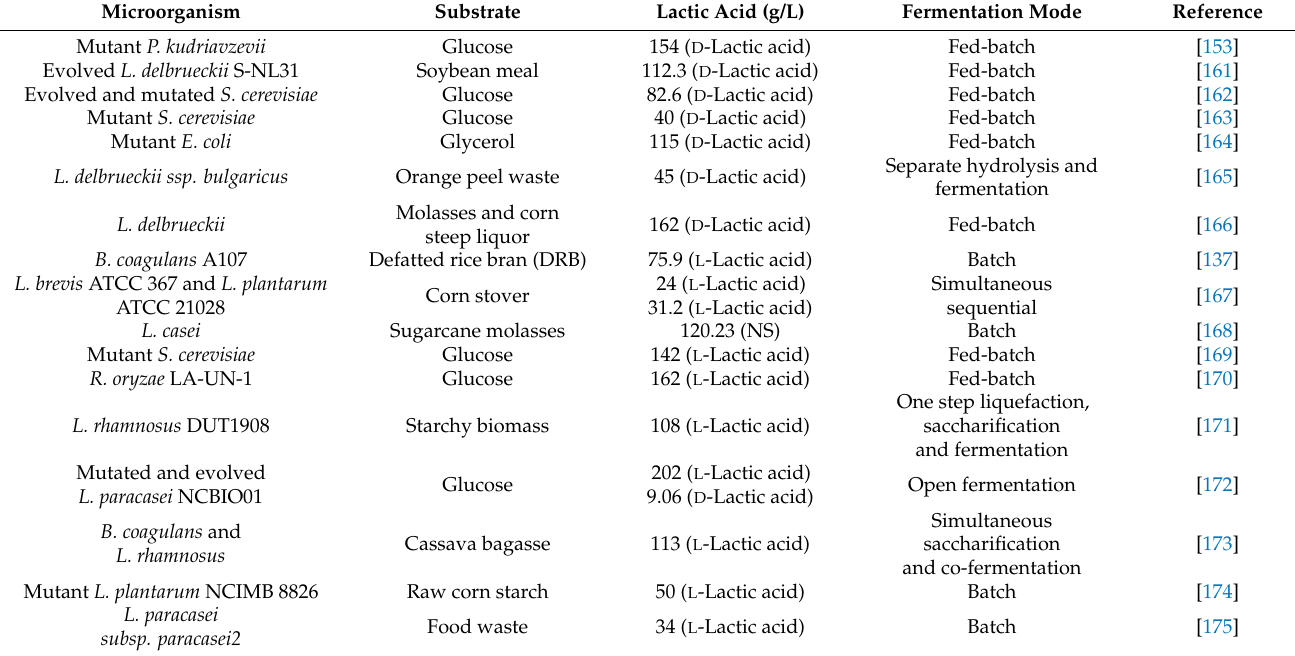
Table 5. Lactic acid production with different substrates, microorganisms and fermentation